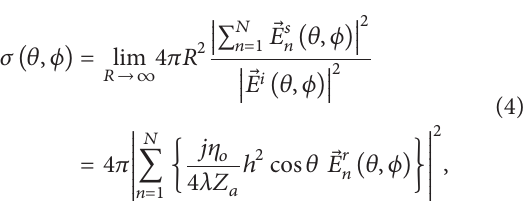
of the dipole elements in side-by-side configuration 𝑛